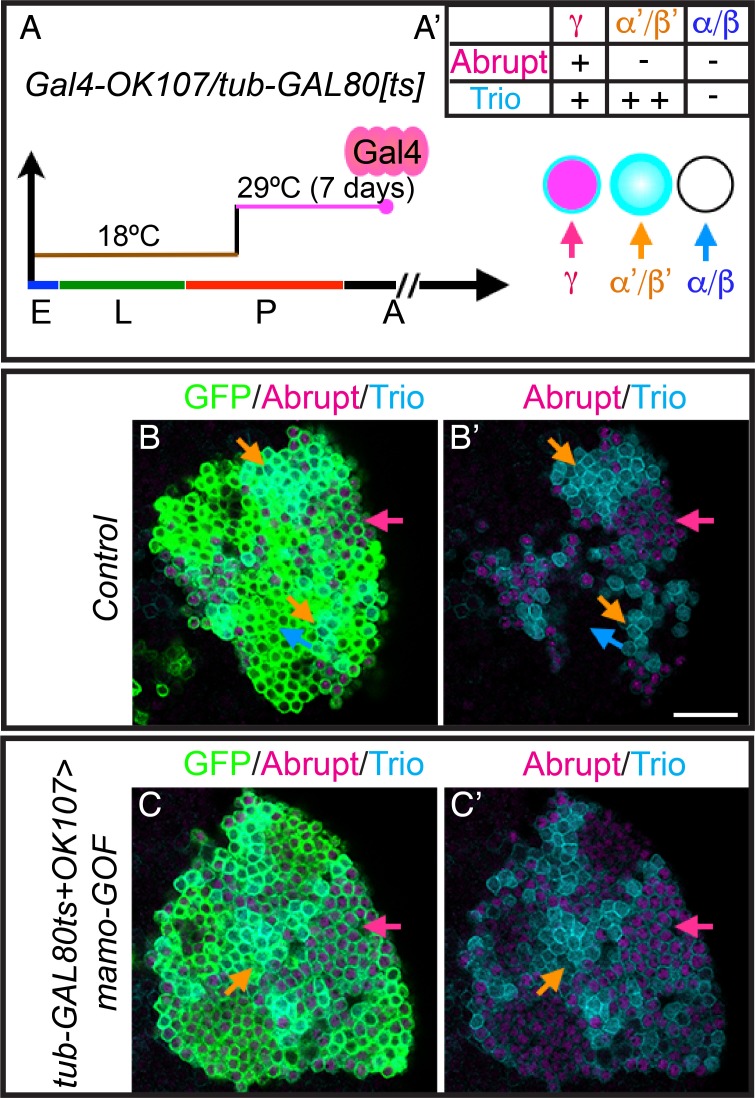
Mamo stimulates α’/β’ specific gene expression.(A) Scheme for temperature shift assay. Heat shock inactivated the temperature-sensitive GAL80 for 7 days at 2 days after pupal formation. (B–C) Adult MB cell bodies (OK107 > GFP+tub-GAL80ts) immunostained for GFP (green) and Abrupt (magenta) and Trio (cyan). Colored arrows identify MB neuron types red=γ ( Trio+PM/Mamo+low ), orange=α’/β’ (Trio+PM,Cyto/ Mamo+high), blue=α/β (Trio-/Mamo-) based on marker expression. Images are representative of n > 6. A single focal plane is shown. Scale bar = 20 μm. Transgene induction at pupal development was more effective at increasing TrioPM,Cyto/Abrupt- cells (C and C’).